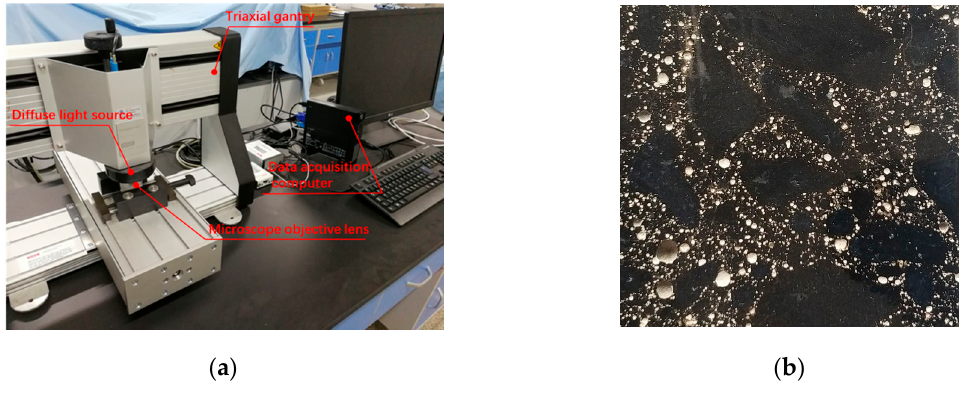
Figure 4. Air-void characteristics test for coal gangue aggregate concrete (CGAC), ( a ) Rapid air concrete air-void analyzer; ( b ) Treated surface of CGAC before air structural testing.